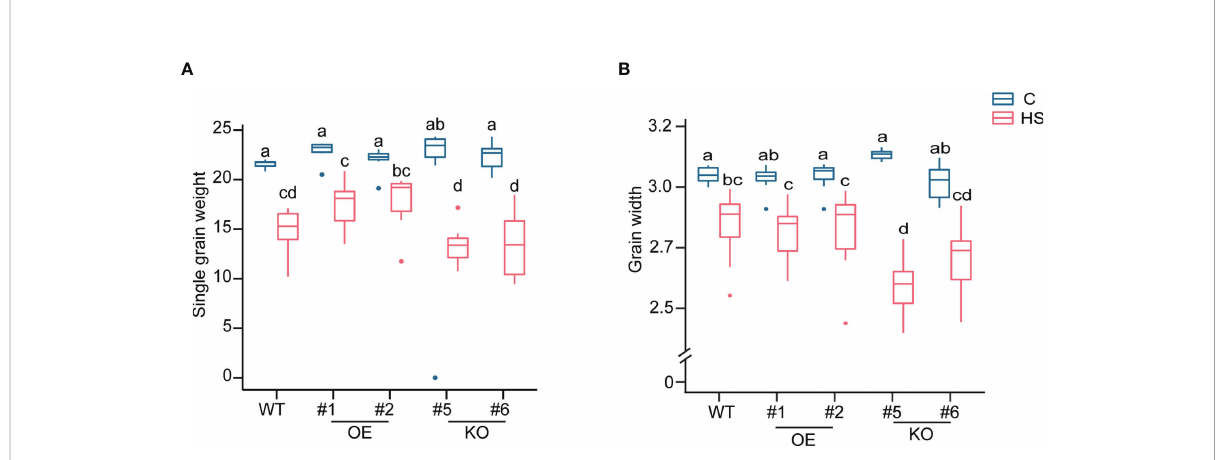
FIGURE 5 Morphometrics differences in single grain weight (SGW) and grain width from WT, KO and OE plants under control and heat stress. (A) SGW (B) Grain width. The signi fi cance level was estimated using two-way ANOVA. N = 6-7 plants. C and HS indicate control and heat stress,